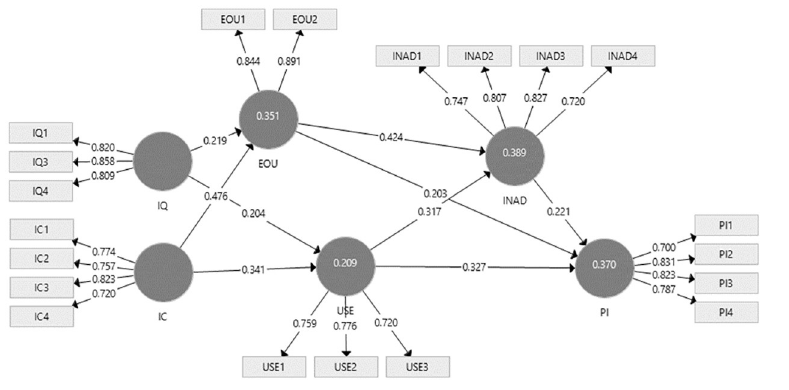
Fig 2. Path coefficients of the